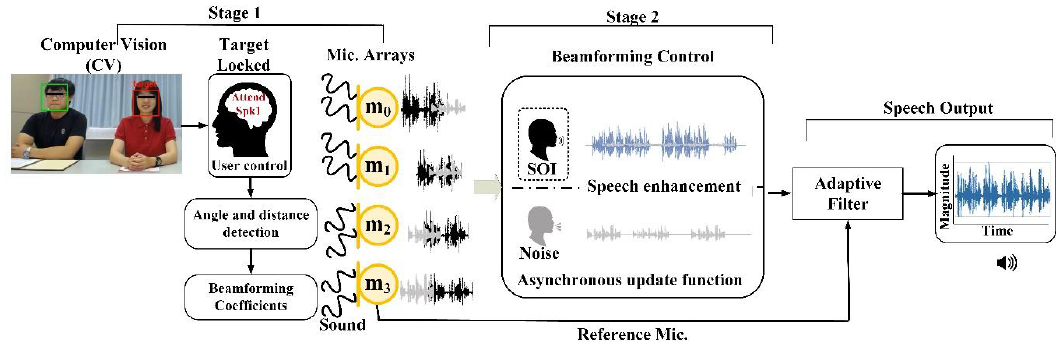
Figure 6. Sound source processing flowchart.